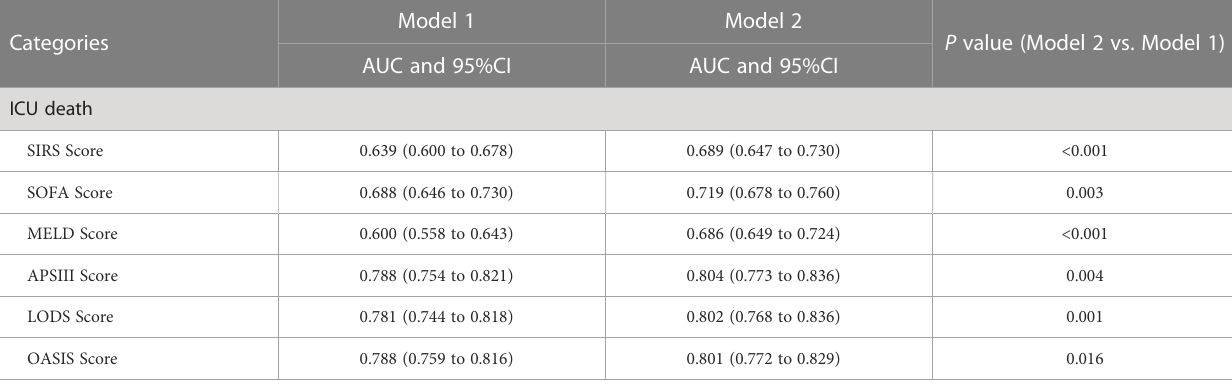
SHR, stress hyperglycemiaratio;ICU, intensive careunit; SOFA, sequential organfailure assessment; LODS, logisticorgan dysfunction system; SIRS, systemicin fl ammatoryresponse syndrome; OASIS, Oxford acute severity score; APS III, acute physiology score III; MELD, model for end-stage liver disease; AUC, area under the curve; CI, con fi dence interval; Model 1, various illness scores; Model 2, various illness